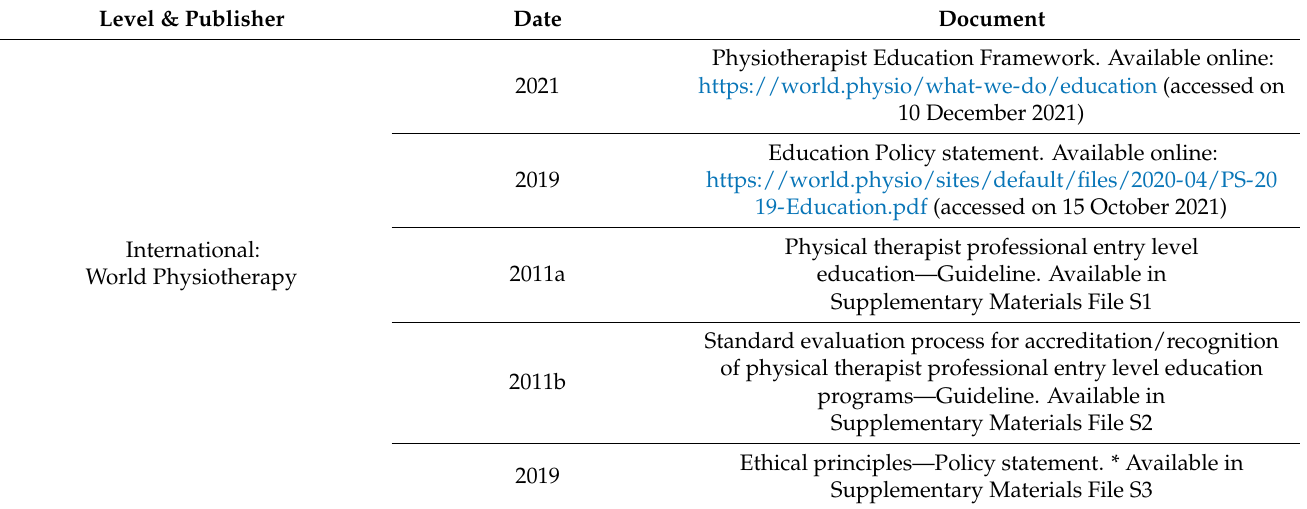
Table 1. Documents included in sequence